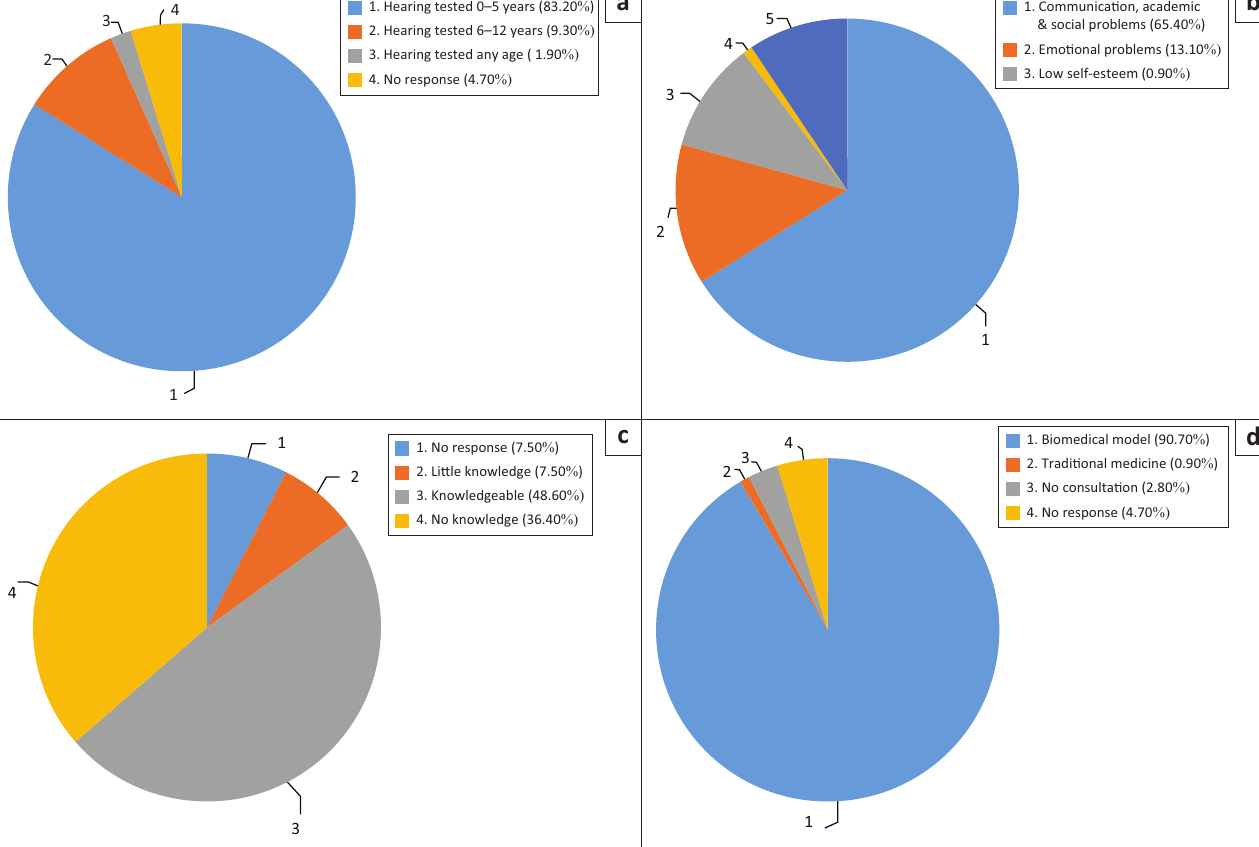
FIGURE 2: Results according to the objectives of the study: (a) Participants’ beliefs regarding at what age hearing can be tested; (b) participants’ opinions regarding consequences of hearing loss; (c) participants’ knowledge of specialists or professionals involved in ears and hearing; (d) participants’ health beliefs